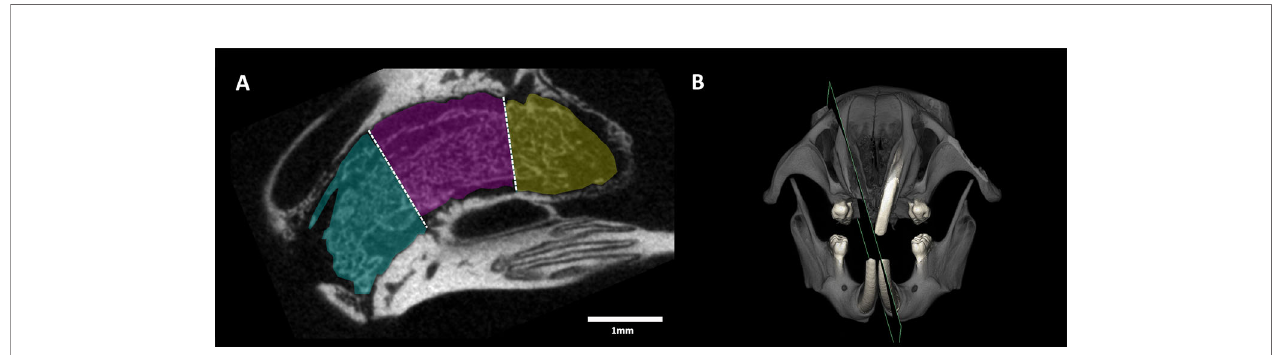
FIGURE 1 | Region of interests (ROI) of the extraction socket for the µCT analysis. (A) The ROIs for the microCT analysis comprised the coronal (cyan), middle (purple) and apical (yellow) region through the entire volume of the tooth extraction site. (B) The plane oriented along the central alveolar socket was the reference for preparing the histological